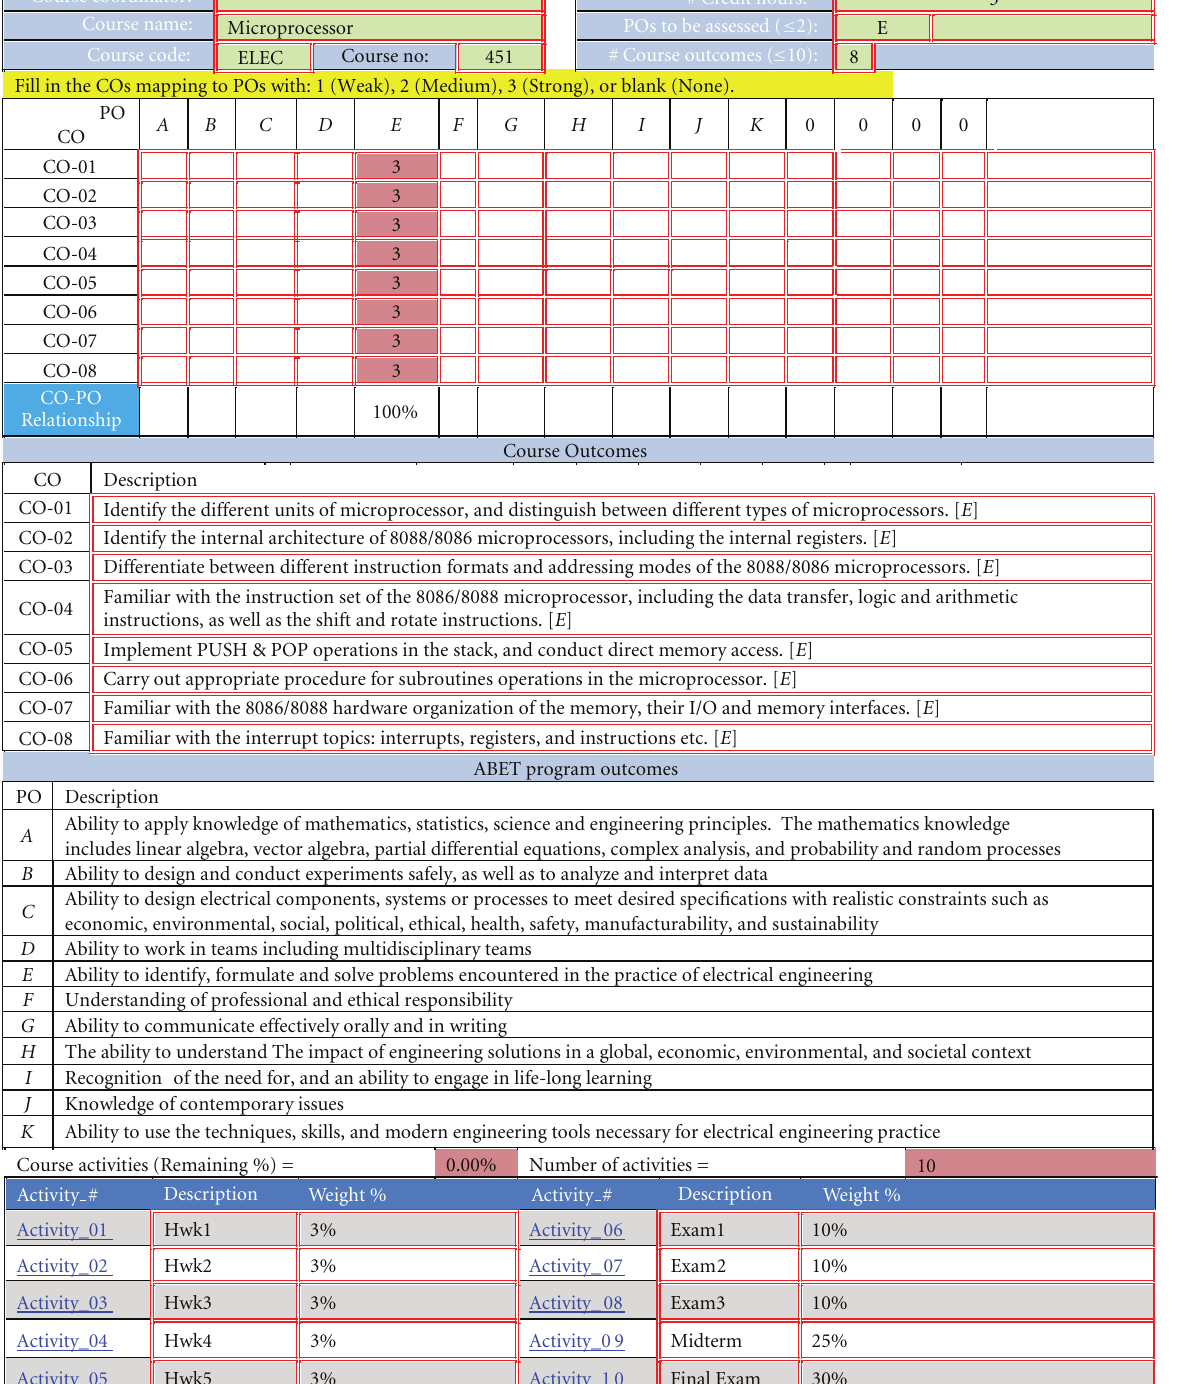
Figure 3: Settings sheet for course